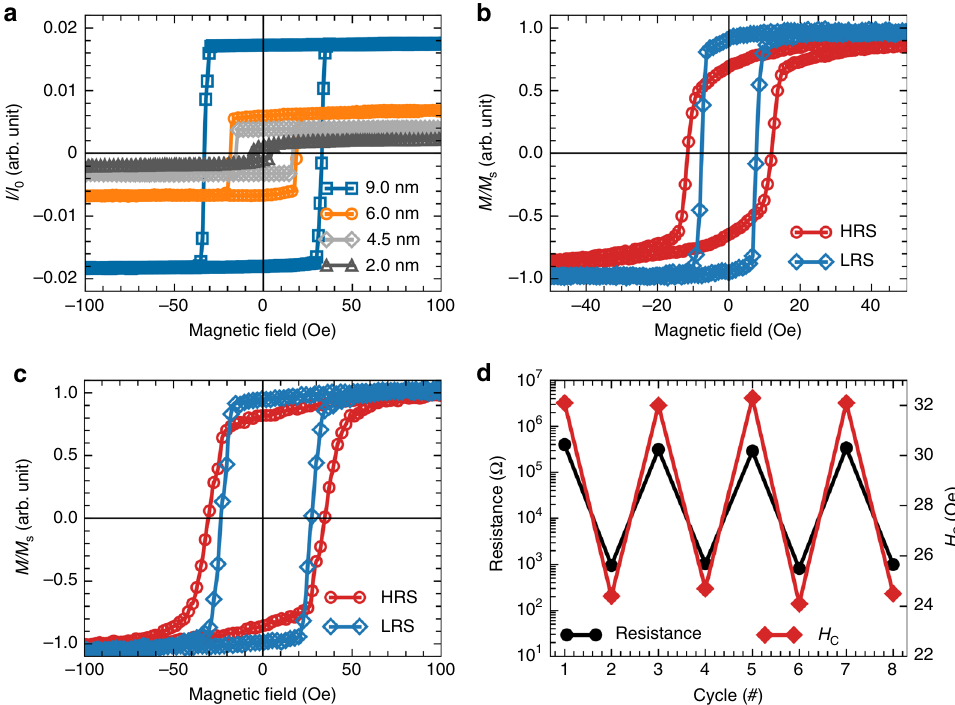
Fig. 2 Room-temperature electric- fi eld control of magnetism. a Longitudinal Kerr signals of pristine Co/SrCoO 2.5 devices with different Co thicknesses. b , c Comparison of the room-temperature magnetic hysteresis loops of Co/SrCoO 2.5 devices at high-resistance (red) and low-resistance (navy blue) states with the thickness of Co layer at b 2.0 nm and c 6.0 nm. d Reversible modulation of the magnetic coercive fi eld for ~6 nm Co sample with different resistance states. The switching voltages are +8 and − 10 V with a duration of 0.6 ms for the HRS and the LRS, respectively. The pads with diameter of ~80 μ m were chosen for the studies, and the distance between the tungsten probe and the laser spot was set at ~20 μ